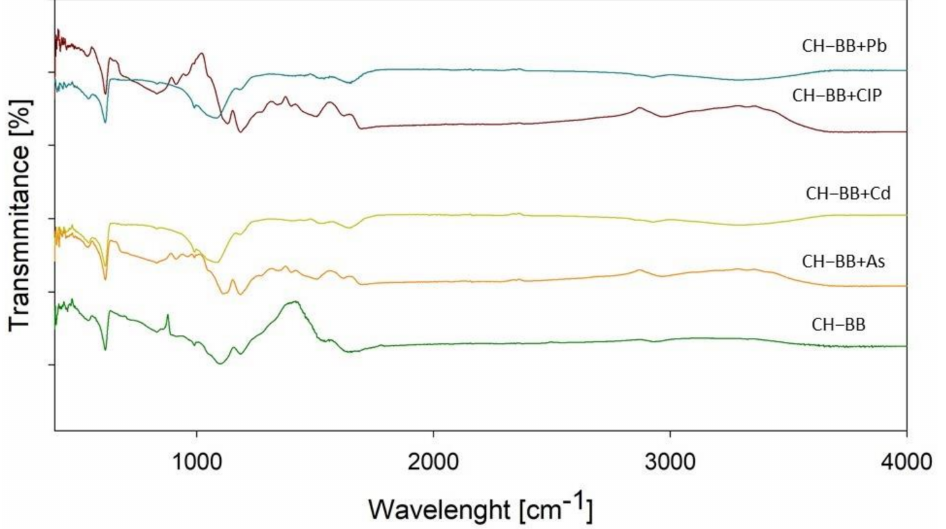
Figure 1. FTIR of CH-BB before and after adsorption of CIP or heavy metals. CH-BB—chitosan- biochar beads;